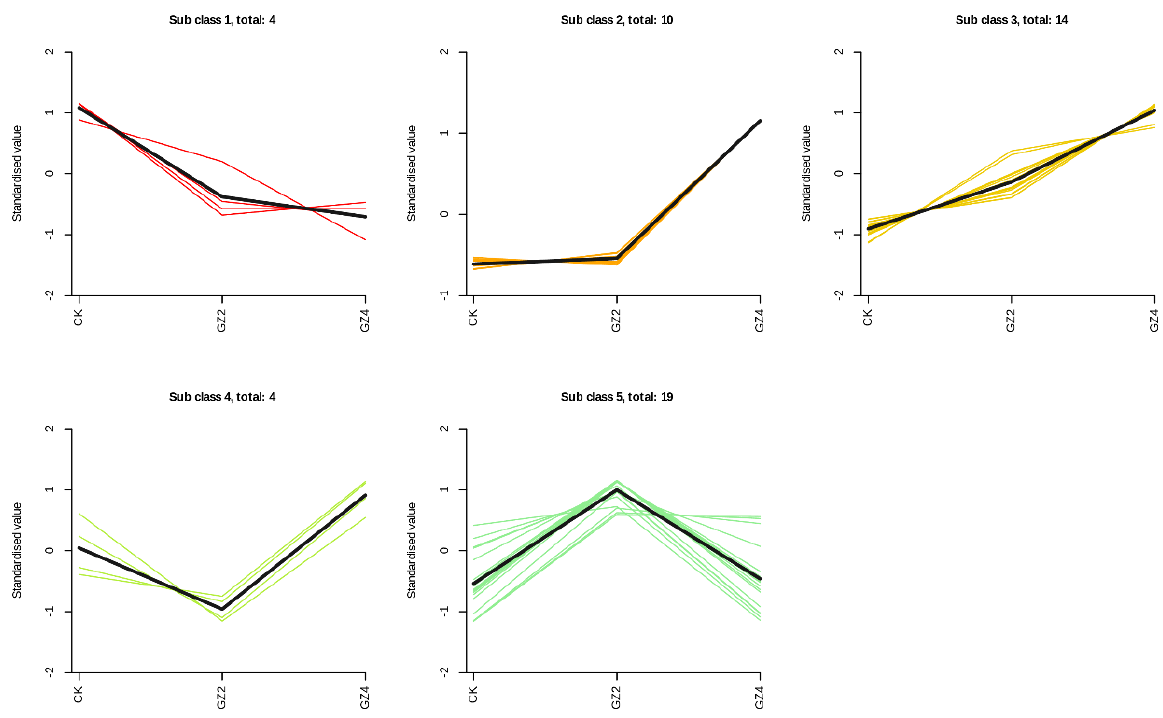
Figure 7. K-means cluster analysis showing the dynamic accumulation of differential metabolites under different concentrations of aluminum.